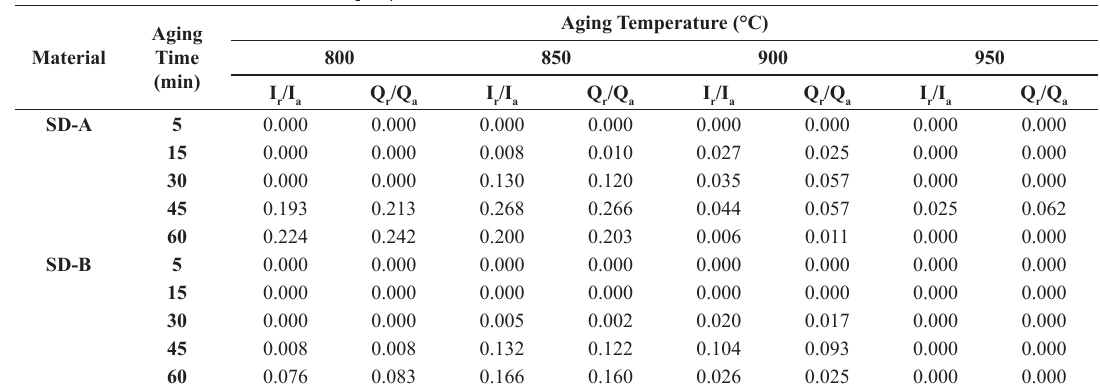
SO + 0.01 M KSCN + 0.50 M NaCl solution test at room 2 4